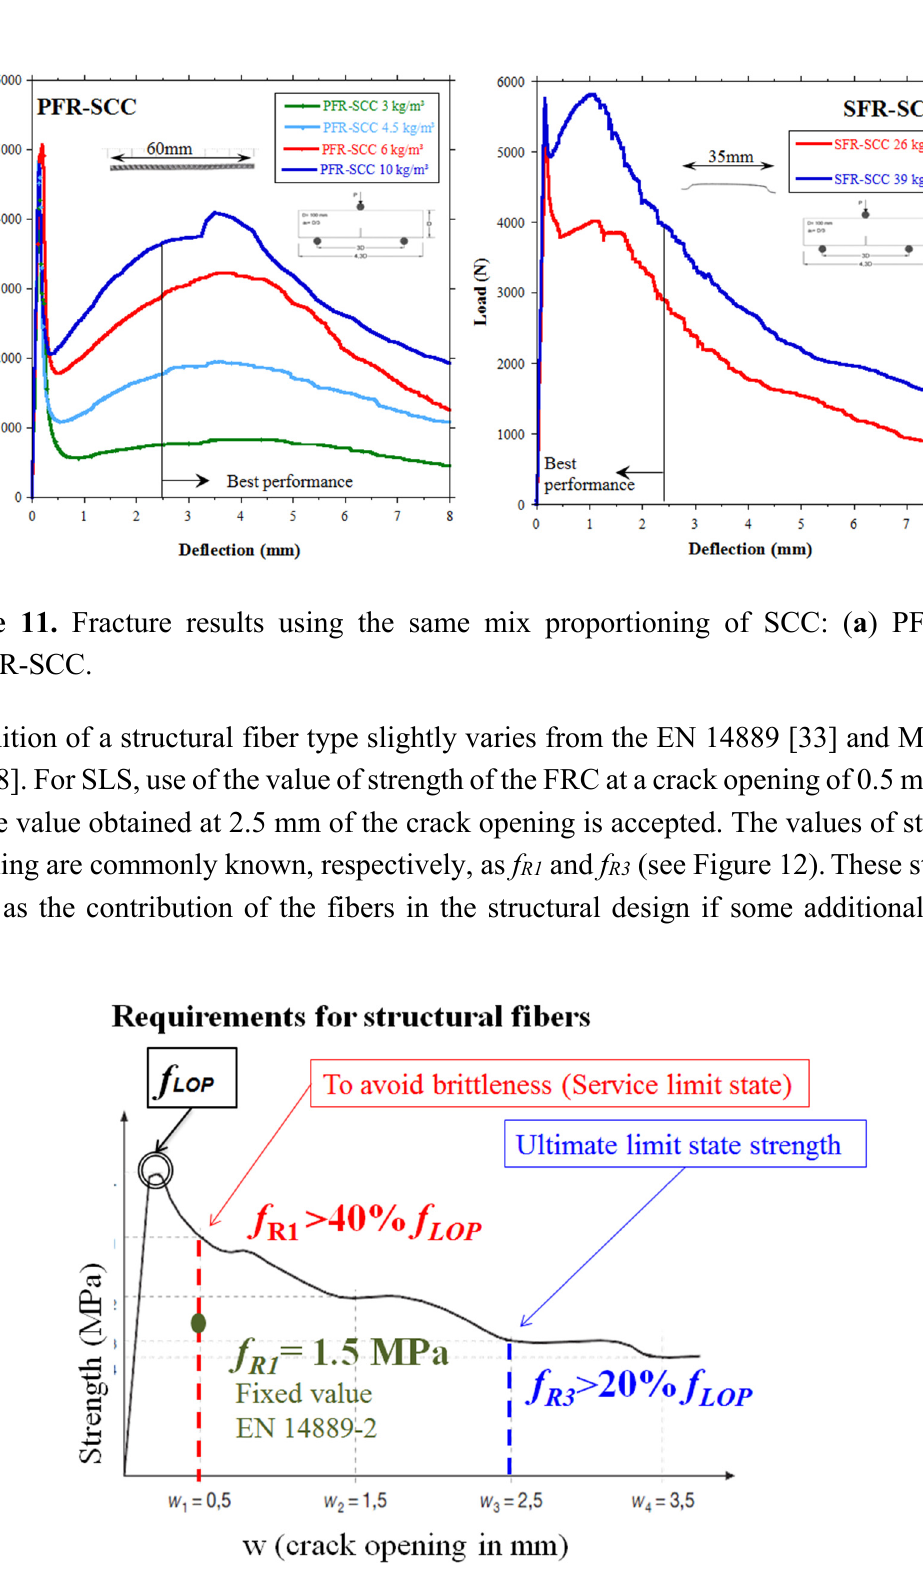
Figure 12. Requirements of the standards to consider the contribution of the fibers in the structural